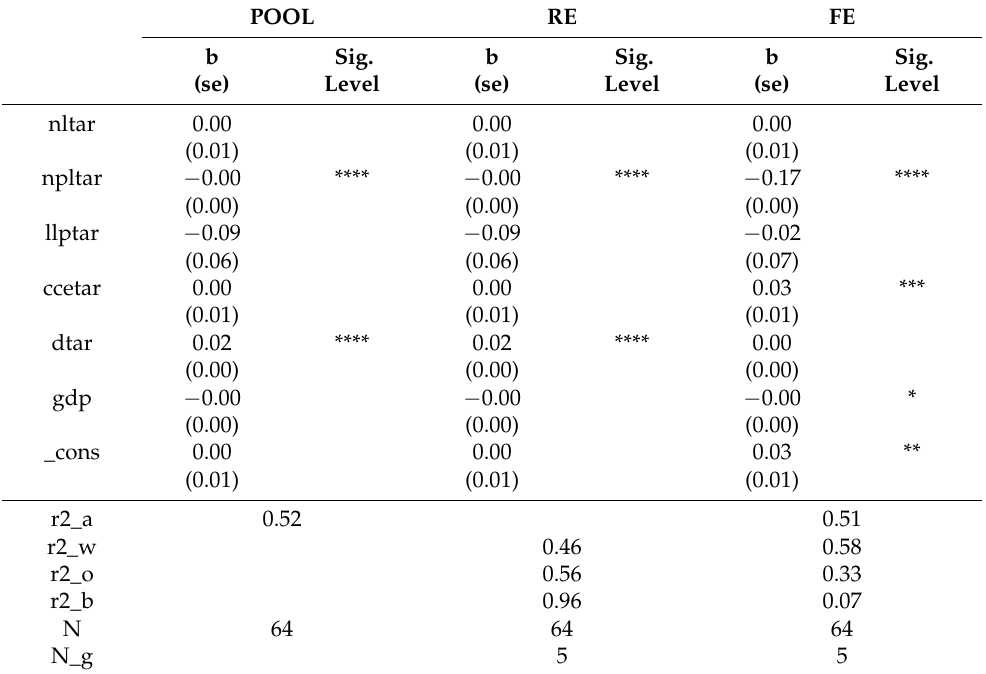
Table 5. Regression results for